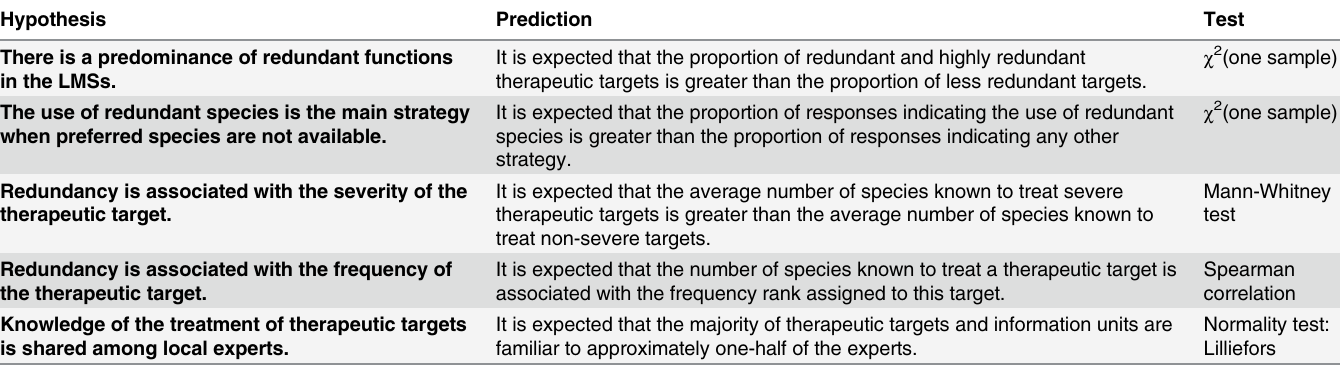
Table 1. Hypotheses and predictions tested in this study and statistical tests employed. Hypothesis Prediction Test